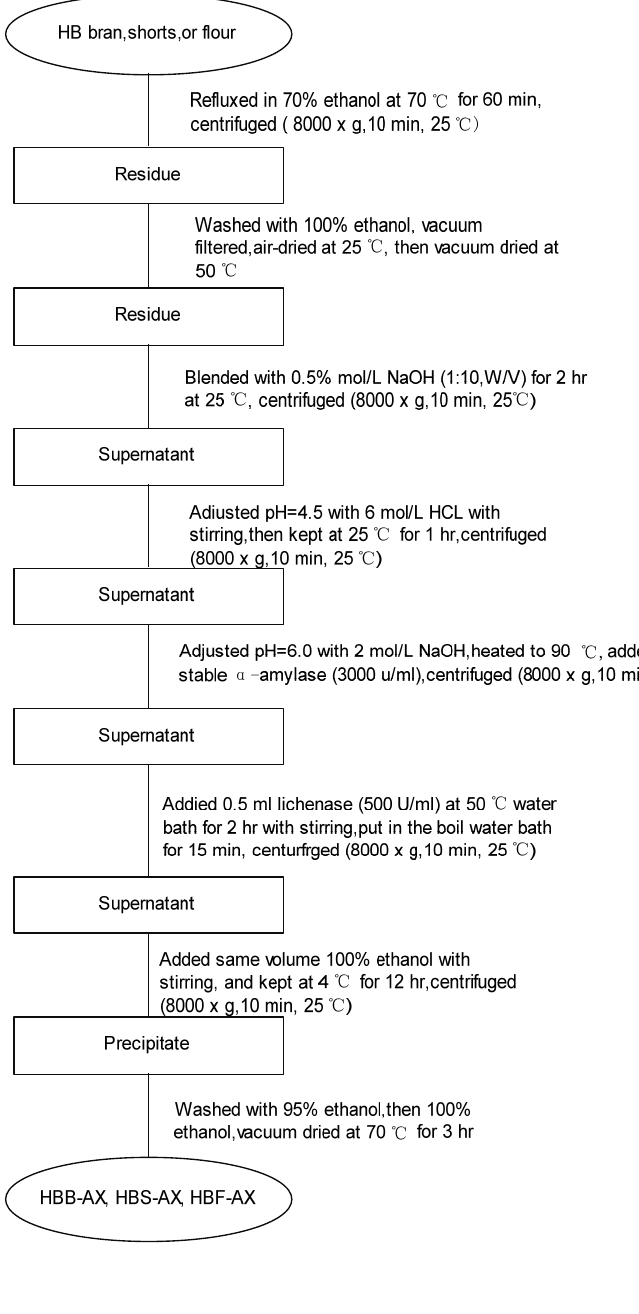
Figure 2. Preparation of arabinoxylans from hull-less bran and shorts and